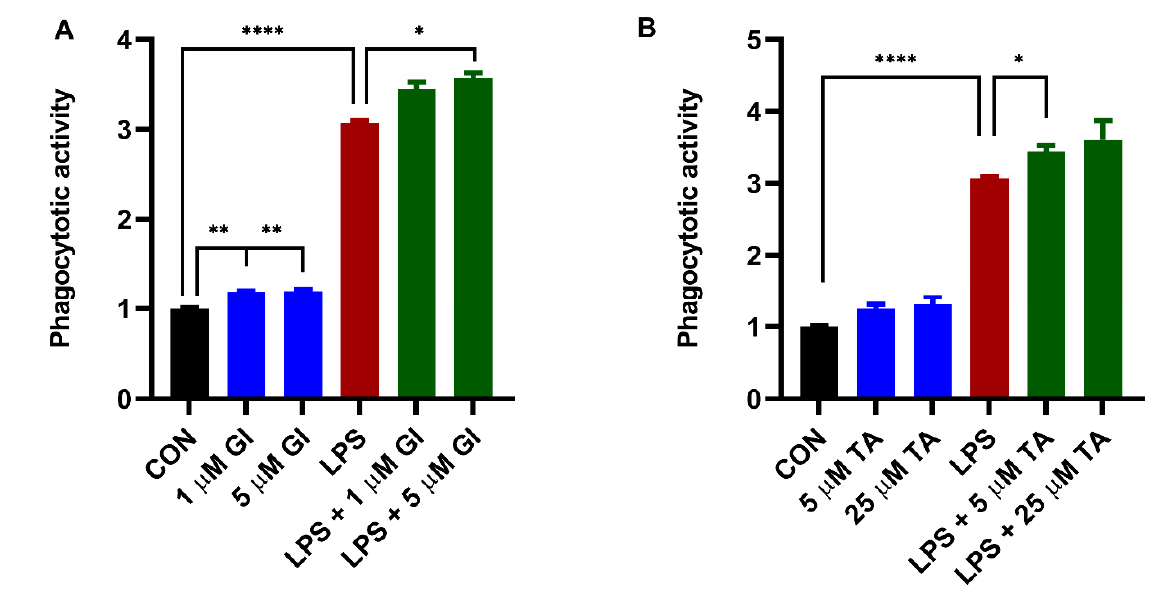
Figure 3. The effect of ADAM10 inhibitor (GI254023X) or ADAM17 inhibitor (TAPI-1) on constitu- tively and LPS-induced BV2 microglial phagocytosis activity. BV2 microglial cells were incubated with GI254023X (1 and 5 µ M) or TAPI-1 (5 and 25 µ M) for 24 h in the absence or presence of 1000 ng/mL LPS. ( A ) The effect of GI254023X treatment on BV2 microglial phagocytosis activity. ( B ) The effect of TAPI-1 treatment on BV2 microglial phagocytosis activity. Black: constitutive phagocytes set on 1; red: LPS-induced phagocytosis; blue: effect of ADAMs inhibitor on constitutive phagocytosis; green: effect of ADAMs inhibitor on LPS-induced phagocytosis. Results were expressed as mean ± SEM. n = 4 from 4 independent experiments. * p < 0.05, ** p < 0.01, **** p < 0.0001.